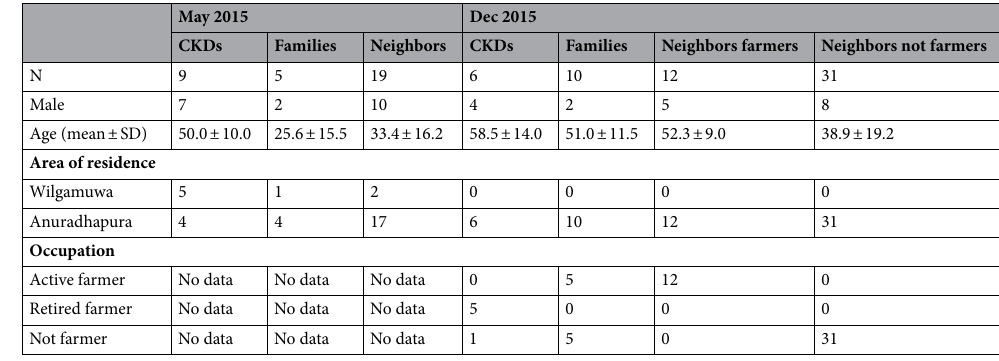
Table 6. Demographic data of 92 participants. CKDs: CKD patients; Families: CKD patients’ family members; Neighbors: healthy individuals living in Wilgamuwa and